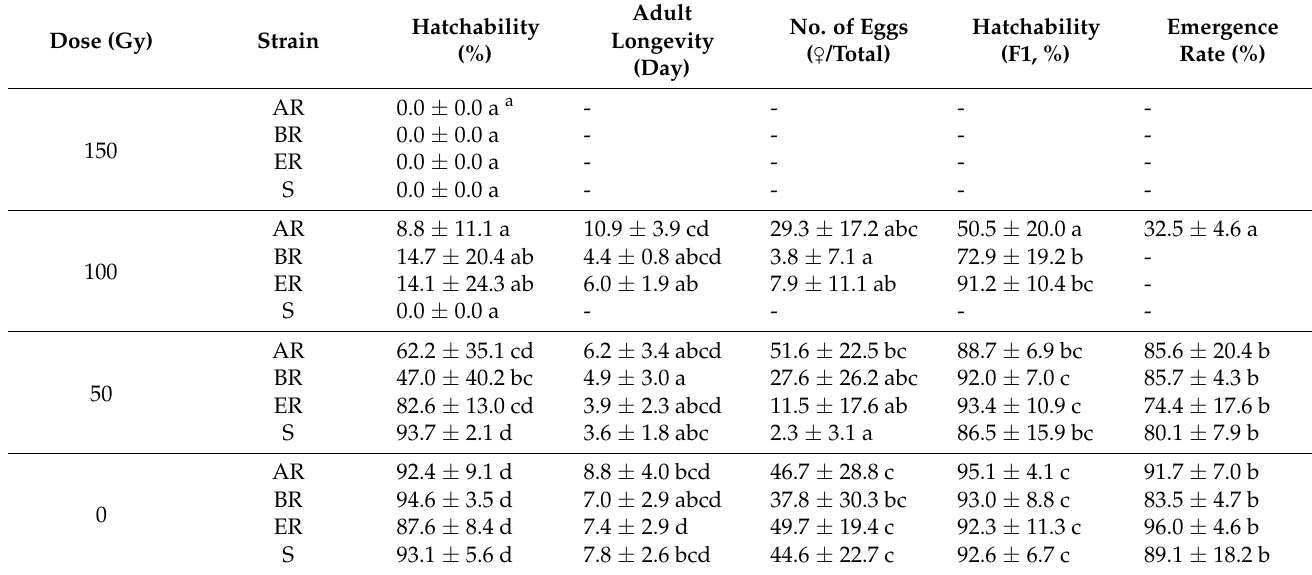
Table 2. Effect of electron beam irradiation on eggs of the AR, BR, ER, and S strains of T. urticae .